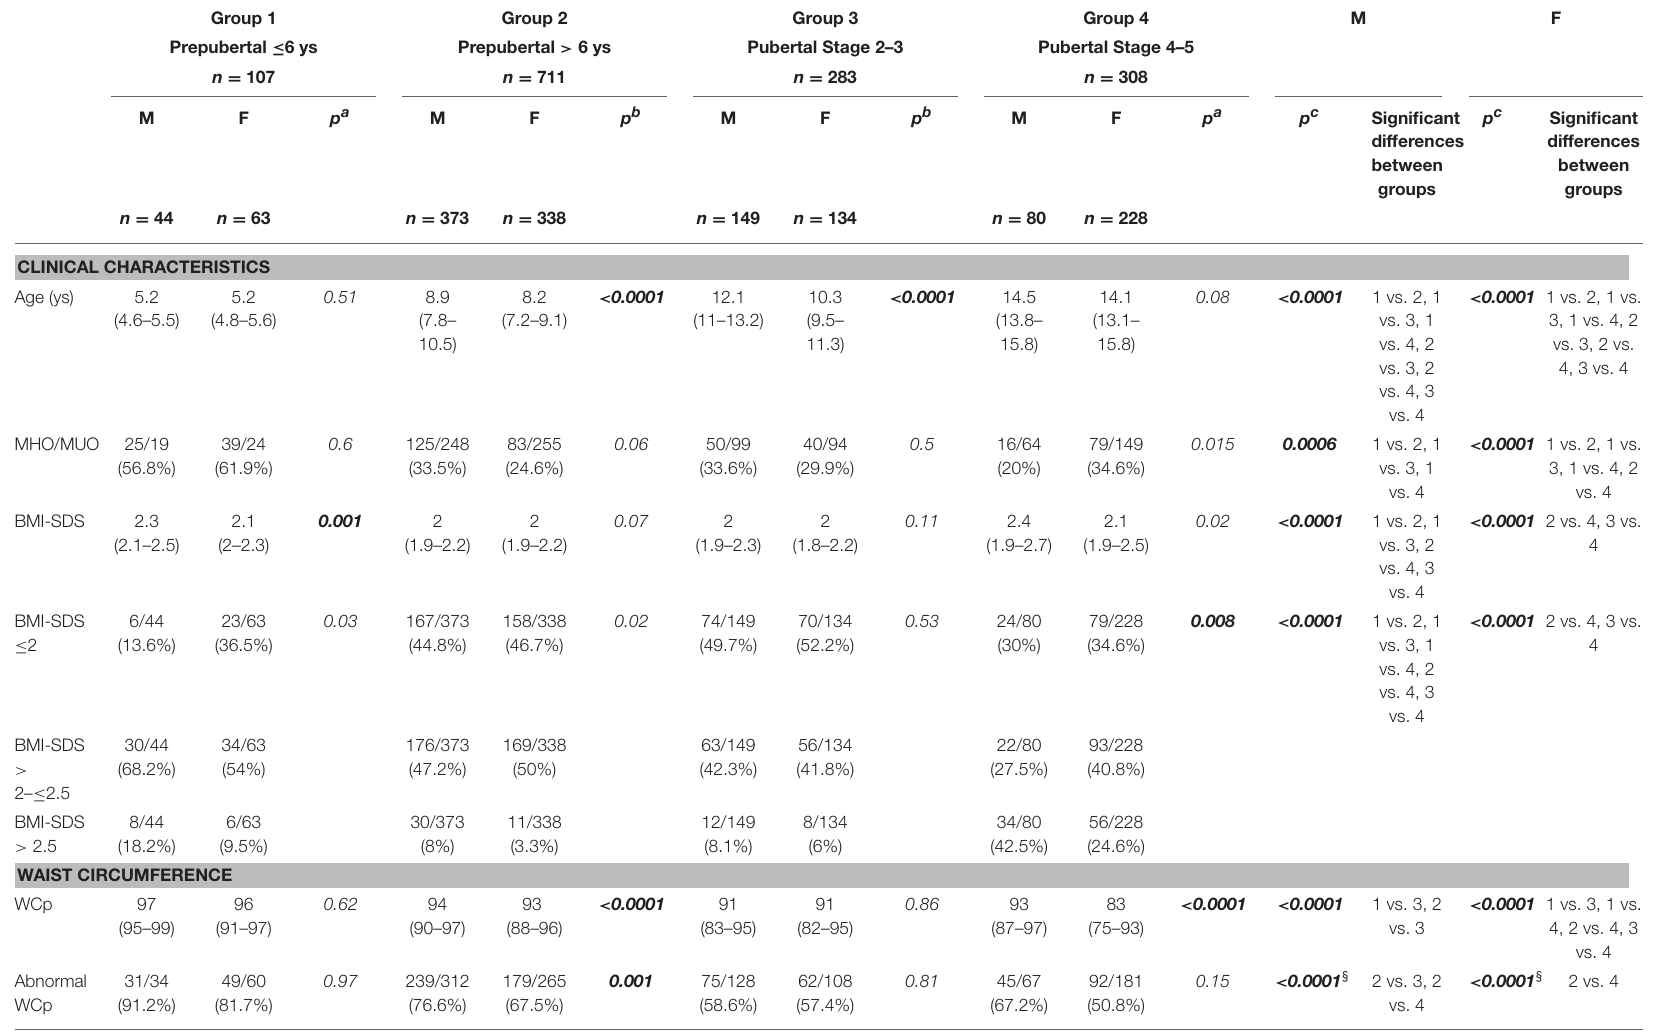
TABLE 2 | Sex and pubertal status differences in CVRF among the 4